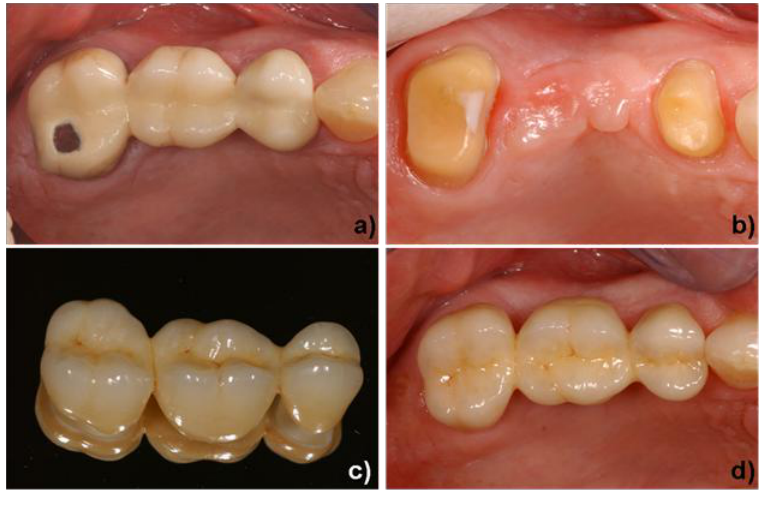
Figure 10. Application of a veneered zirconium oxide ceramic. a) initial situation (tooth #24–27), damaged PFM bridge. b) preparation of tooth #24 and #27 for a veneered zirconium oxide 3-unit bridge restoration (IPS e.max  ZirCAD), teeth #25 and #26 have been extracted. c) all-ceramic bridge on a mirror; the high-strength, white IPS e.max  ZirCAD framework is veneered by a fluoroapatite glass-ceramic (IPS e.max  Ceram). d) final clinical situation after cementation with a glass ionomer cement. Dentist: A. Peschke; Dental technician: F. Perkon (both Ivoclar Vivadent